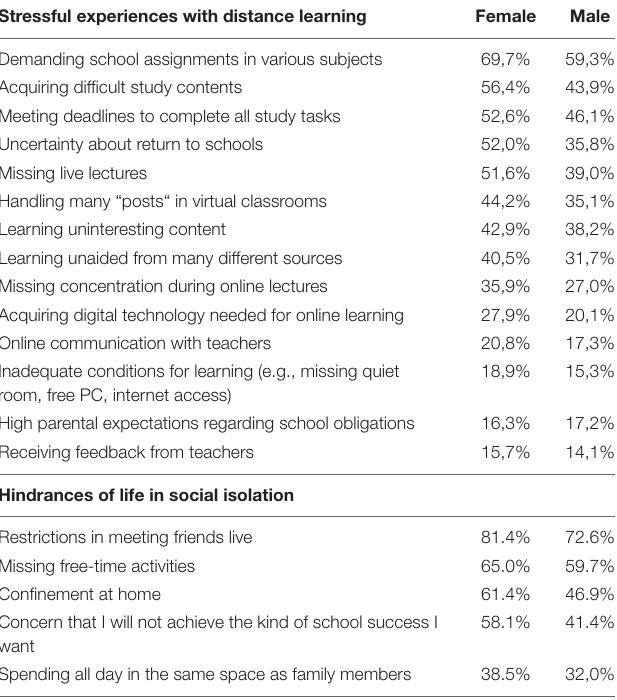
TABLE 1 | Types and intensity of stressful experiences with distance learning and life in social isolation by